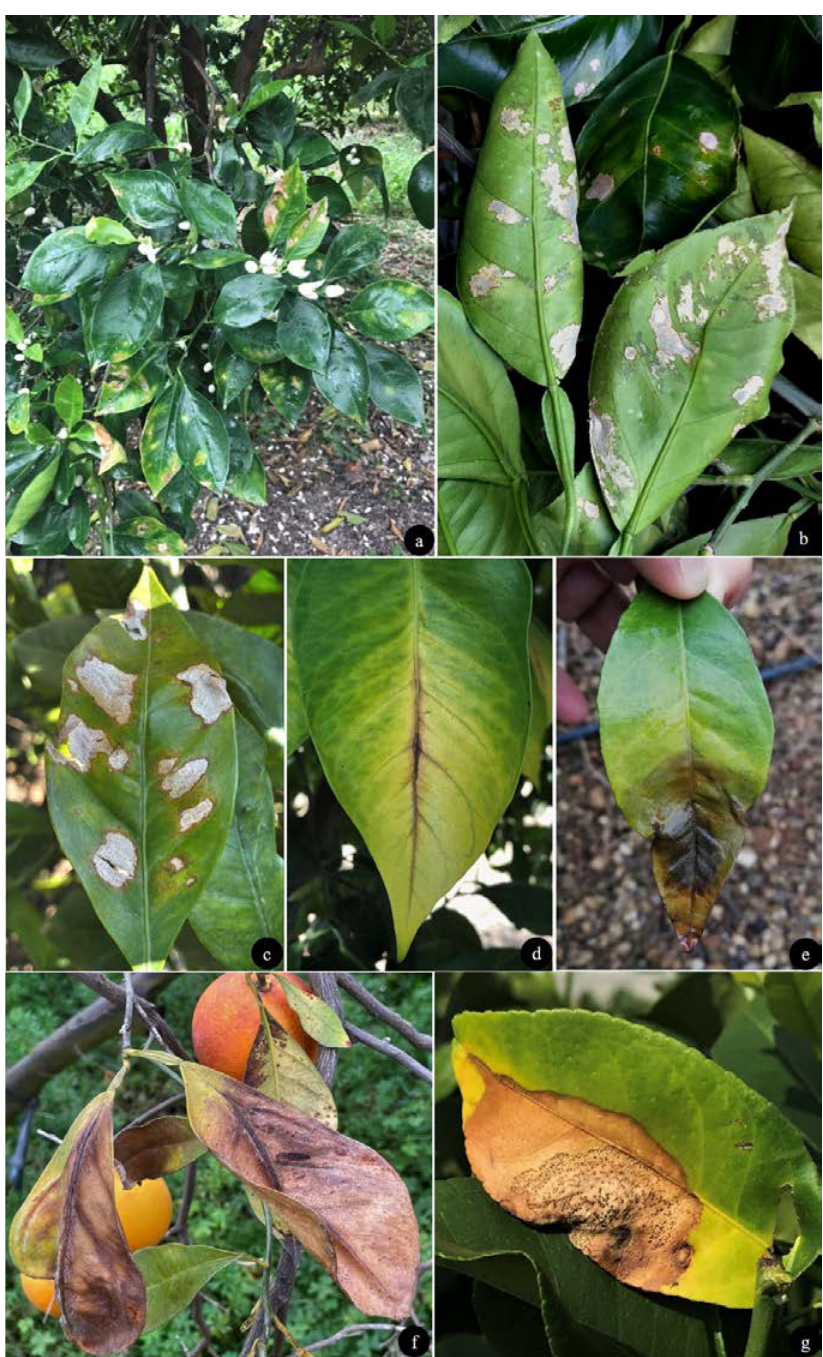
Figure 3. Anthracnose on leaf: ( a ) severe anthracnose on leaves of “Mandared” mandarin; ( b ) mesophyll collapse associated with anthracnose on bottom and top leaf pages of “Tarocco Lempso”; ( c ) irregular blighted grey to light brown lesions with a prominent purple margin and presence of fungal black acervuli on dead tissues; ( d , e ) leaf vein necrosis, leaf yellowing and tip wilting; ( f ) leaf blight; ( g ) anthracnose lesion on “Femminello Siracusano 2KR” after hail damage under humid condition.